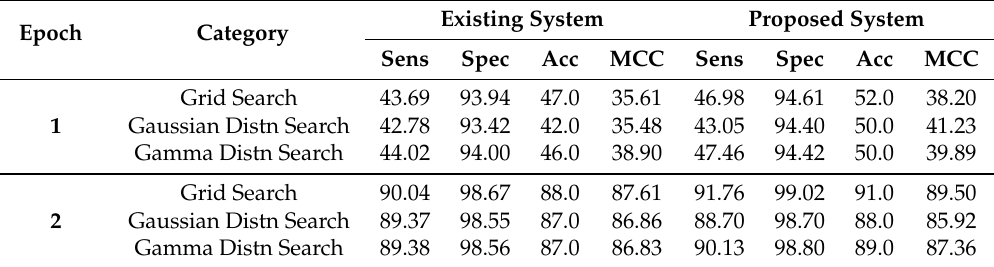
Table 3. Comparison of random search, Gaussian distribution search, and Gamma distribution search using 400 traing data set and 100 validation data